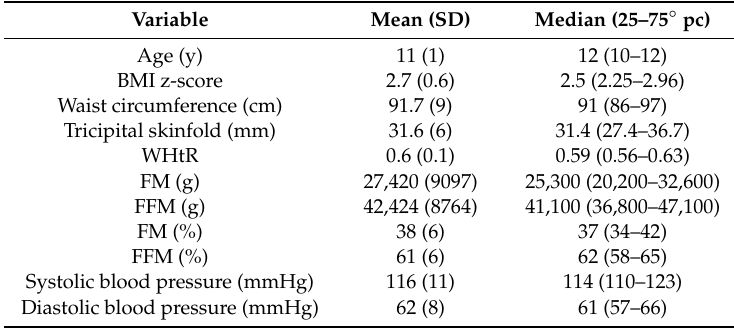
Table 1. Anthropometric parameters. BMI, body mass index, WHtR, waist-to-height ratio, FM, fat mass, FFM, fat-free